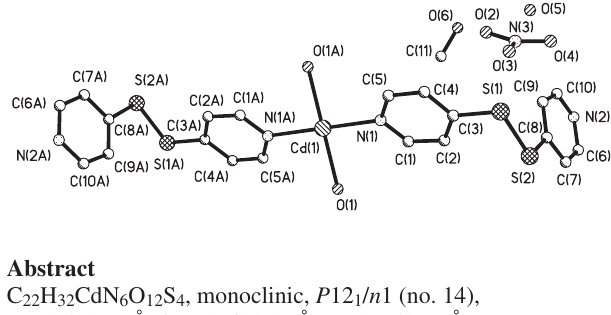
Table 1. Data collection and handling.